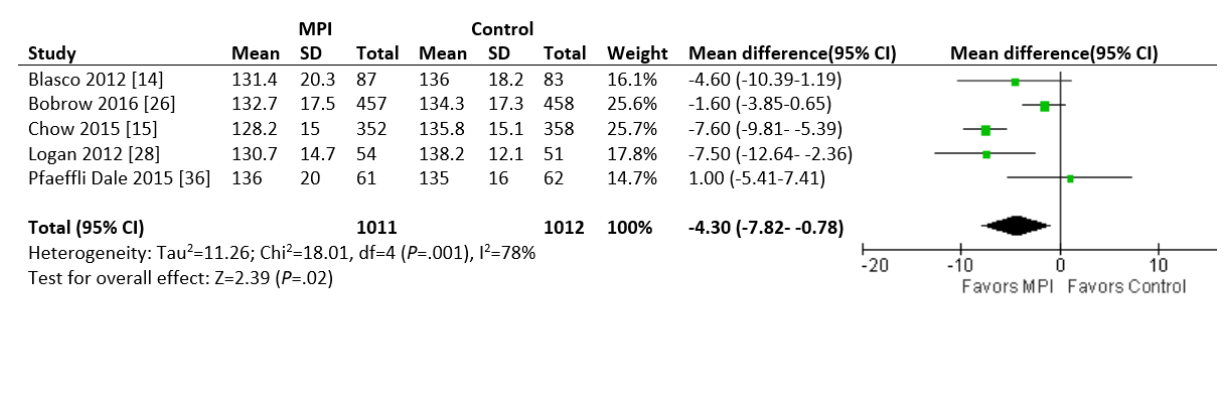
Figure 5. Forest plot of the mean difference in blood pressure in patients with hypertension who were involved in randomized controlled trials comparing a mobile phone intervention versus control. The mean difference of each trial corresponds to the middle of the squares, and the horizontal line shows the 95% CI. The summary mean difference is represented by the middle of the solid diamond. A test of heterogeneity is given below the summary statistics. MPI: mobile phone intervention, df: degrees of